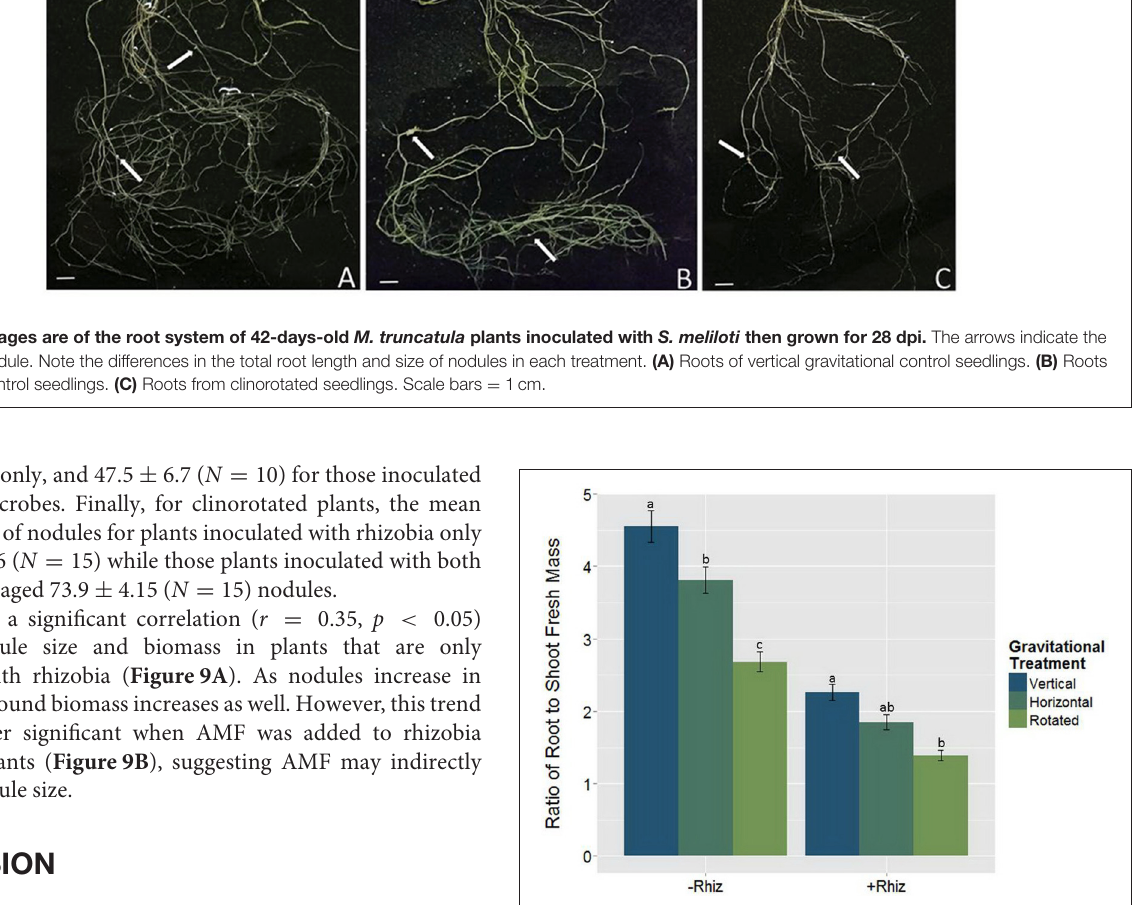
FIGURE 6 | The root:shoot fresh mass ratio responding to the significant rhizobia × gravitational treatment interaction ( p < 0.05). The root:shoot fresh mass reduces with clinorotation and the addition of rhizobia ( + Rhizobia). Rhizobia + clinorotated treatments ( n = 30 ) have a significantly smaller root to shoot mass ratio than vertical controls ( p < 0.05; n = 39 ). Plants without nodules ( − Rhizobia; n = 117 ) have a higher root:shoot fresh mass ratio than + Rhizobia ( p < 0.05 ; n = 69 ). The letters above each standard error bar denote significance between rhizobia